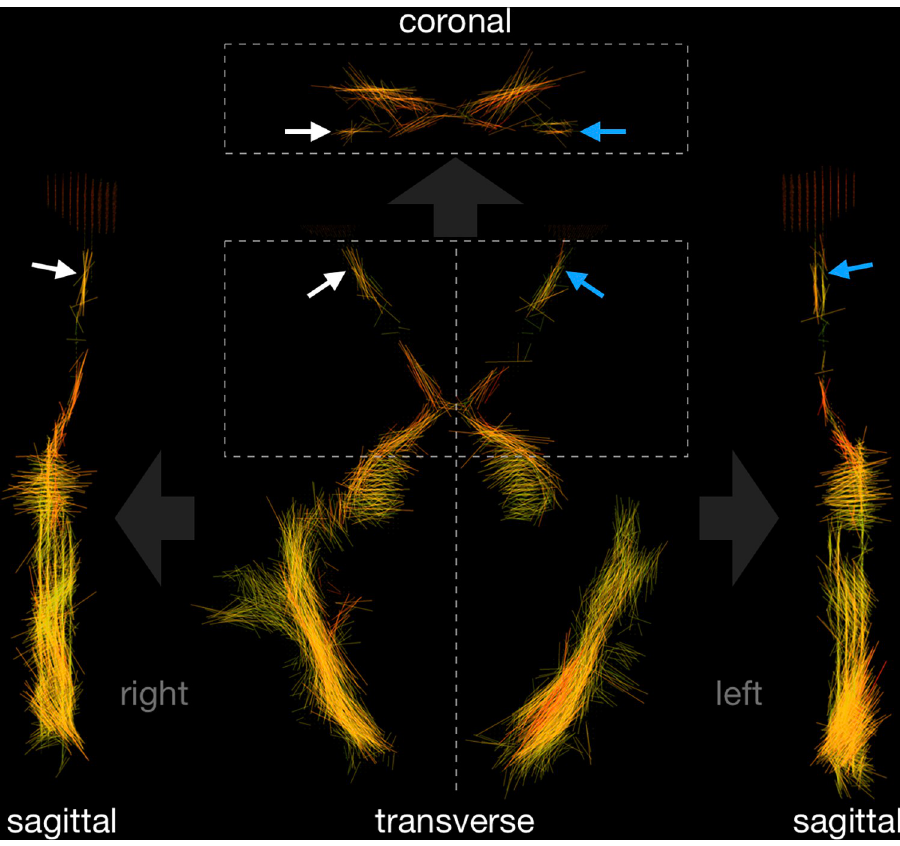
Fig 3. Visual pathway shape on different plane projections. White and blue arrows indicate right and left optic nerve, respectively. Real voxel proportions are preserved.